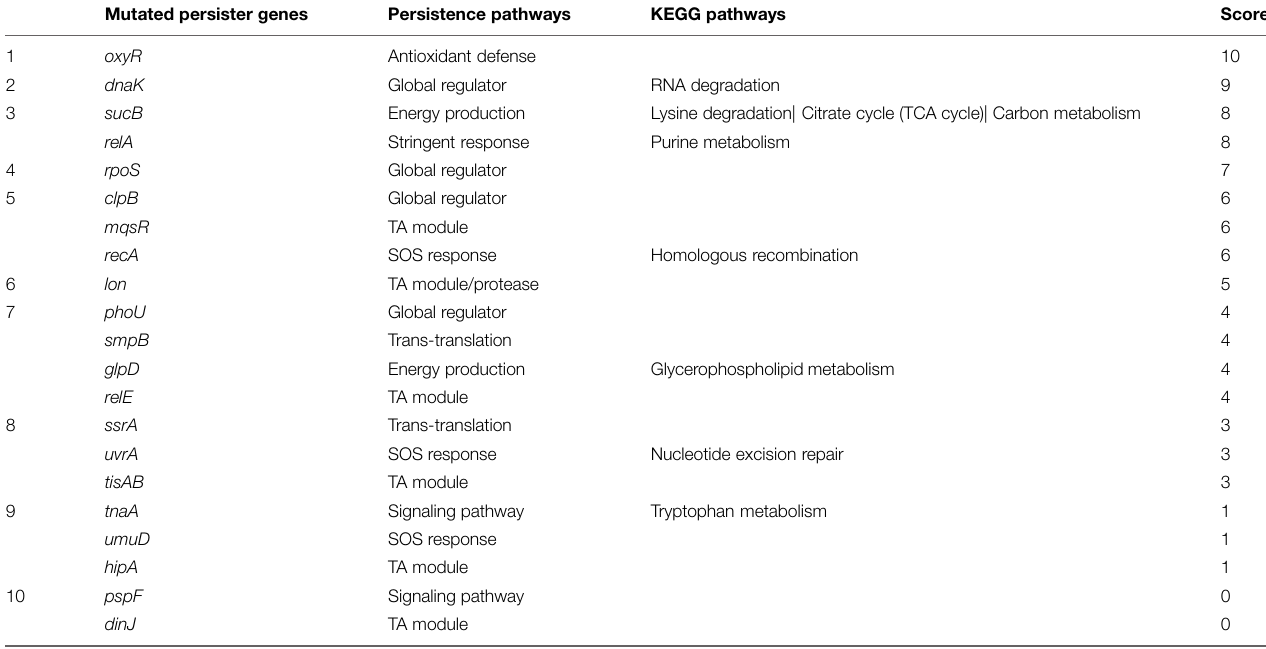
TABLE 1 | Comprehensive ranking of persister genes and pathways according to scores ∗